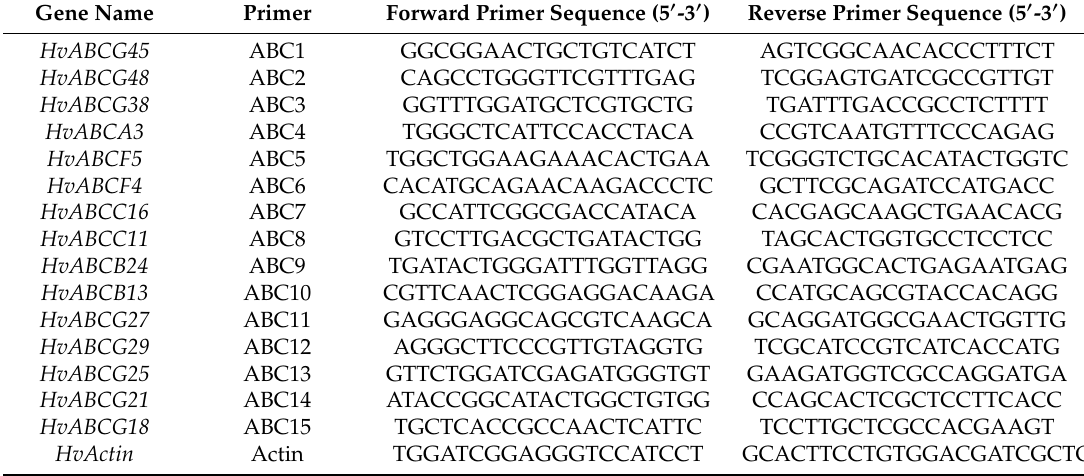
Table 1. Primer sequence used for qRT-PCR amplification of ABC gene family in